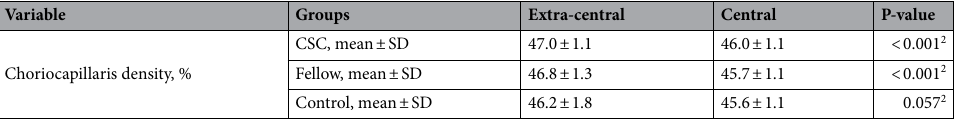
Table 4. Comparisons of choriocapillaris density between central and extra-central subfields in CSC, fellow and control eyes. Data are presented as means ± standard deviations unless otherwise indicated. CSC central serous chorioretinopathy. 1 The paired t test for parameters with normal distribution. 2 The Wilcoxon matched- pairs signed rank test for parameters with nonnormal